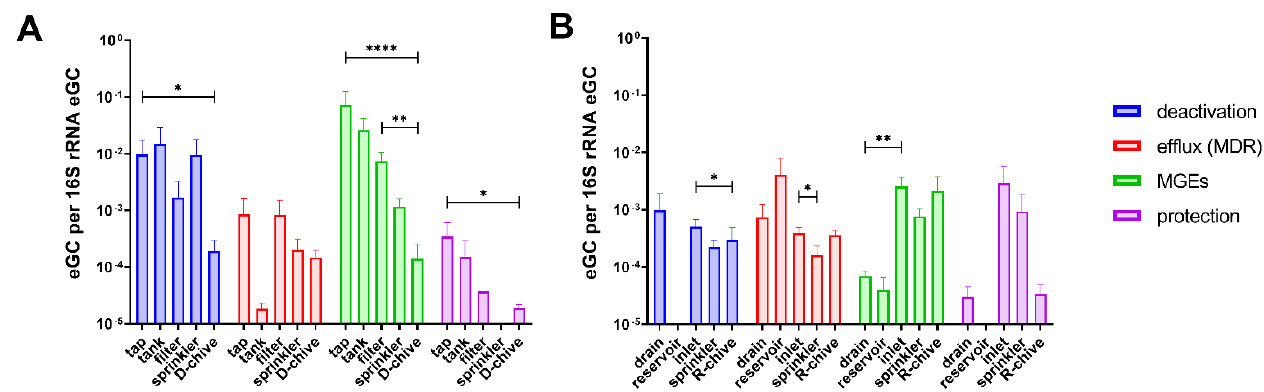
Figure 2. Mean estimated genomic copies (eGC) of ARGs relative to 16S rRNA eGC detected in sampling-1 along the irrigation chains, grouped by ARG function. ( A ) D-system, including tap, tank, sterile filtered, and sprinkler water, as well as D-chive; ( B ) R-system including drain, open-top reservoir, greenhouse inlet, and sprinkler water, as well as R-chive. Statistical significance is indicated: *, p < 0.05; **, p < 0.01; ****, p < 0.0001. Error bars show standard error of the mean.